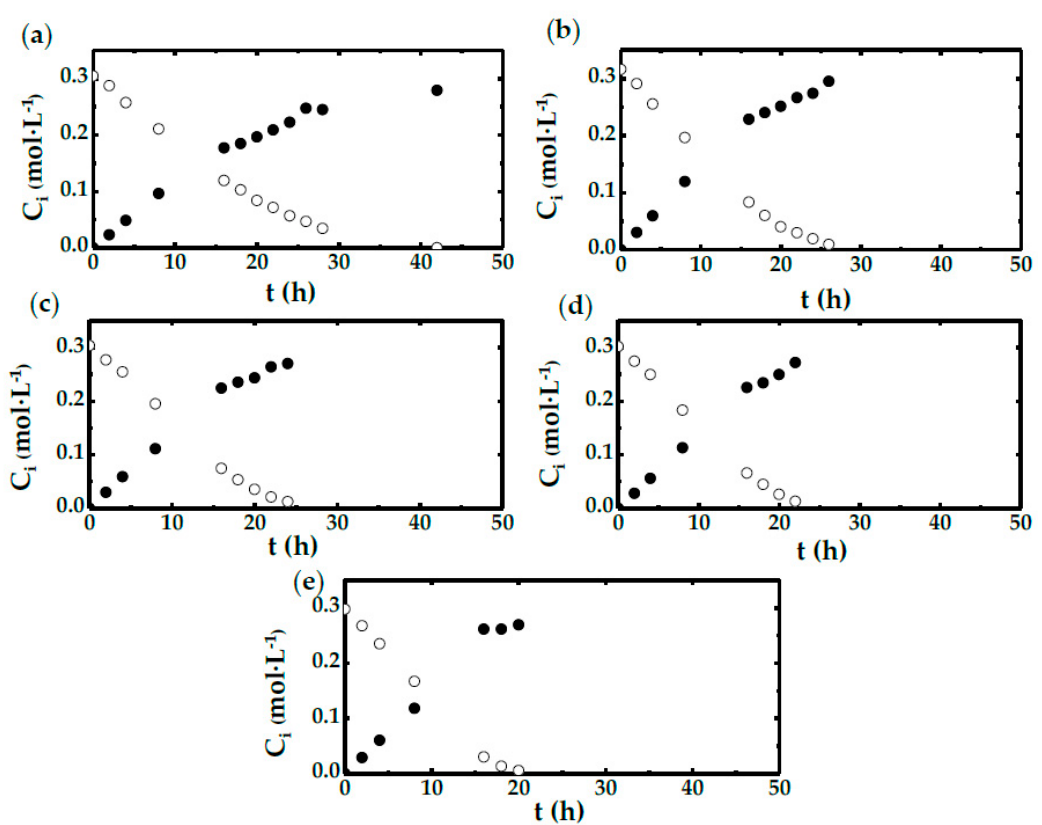
Figure 2. Experimental results. DHA ( ● ) and glycerol ( ○ ) concentrations vs. time for runs 7 to 11 (see Table 1) carried out in shake flasks. All runs conducted at agitation speed of 200 rpm employing different biomass concentrations according to ( a ) 0.2, ( b ) 0.3, ( c ) 0.4, ( d ) 0.5, and ( e ) 1.0 g·L − 1 .